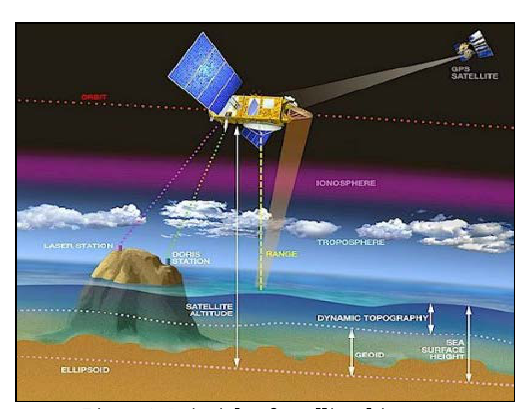
Figure 1. Principle of satellite altimetry (Fu and Cazenave,